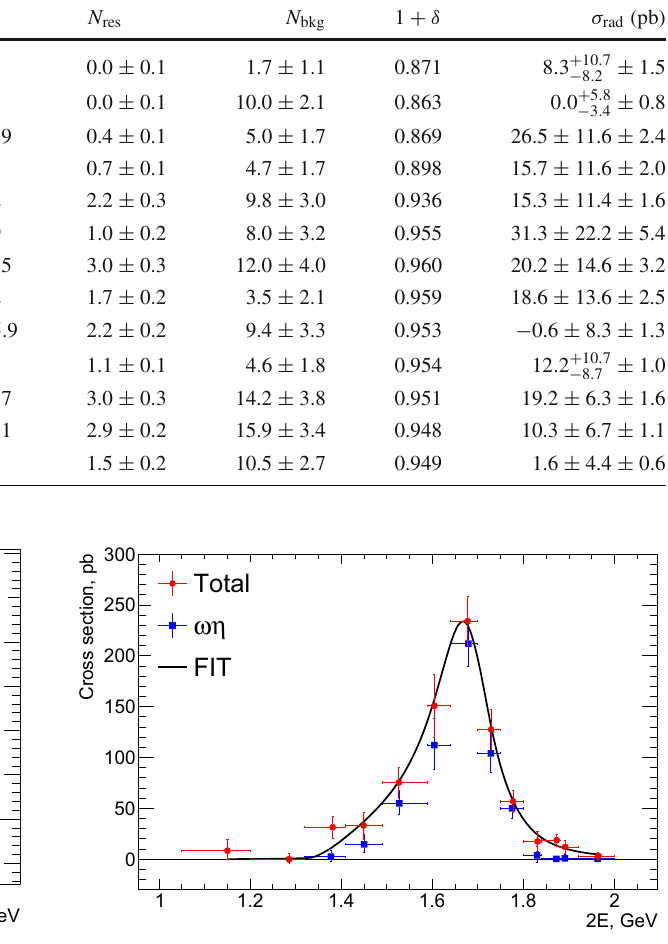
Fig. 5 The measured Born cross section for the process e + e − → rad- ηπ 0 γ (points with error bars). The curve is the result of the fit described in the text